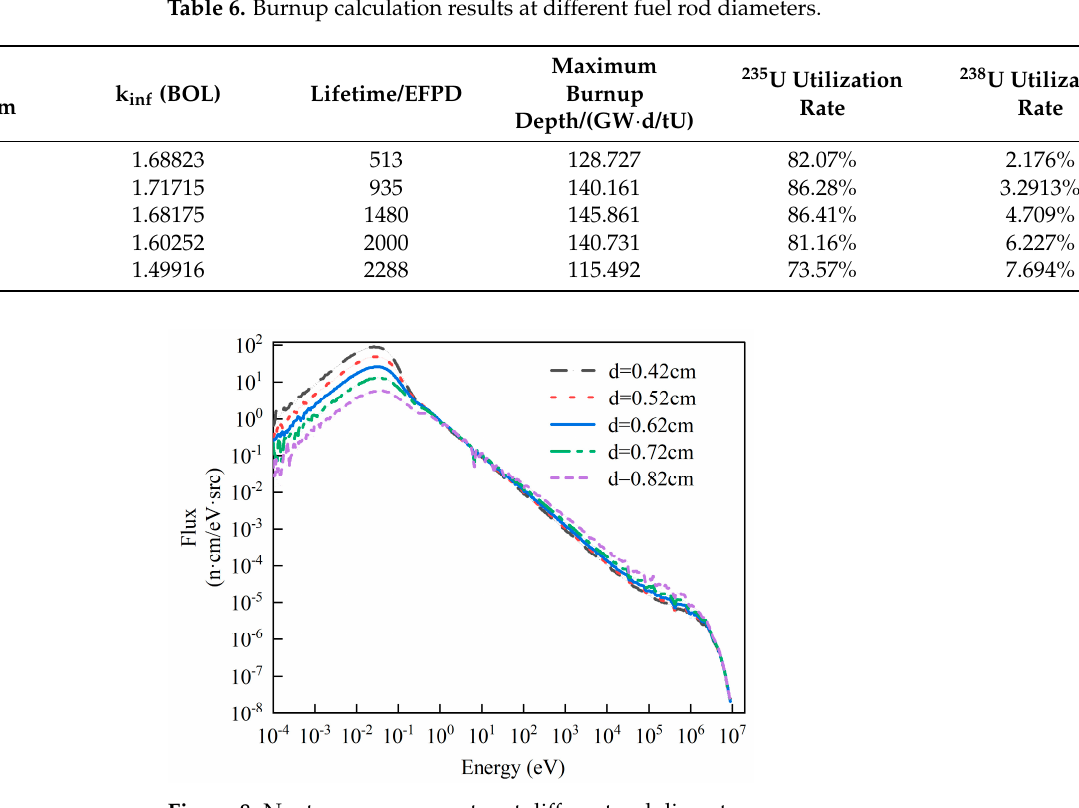
Figure 8. Neutron energy spectra at different rod diameters.